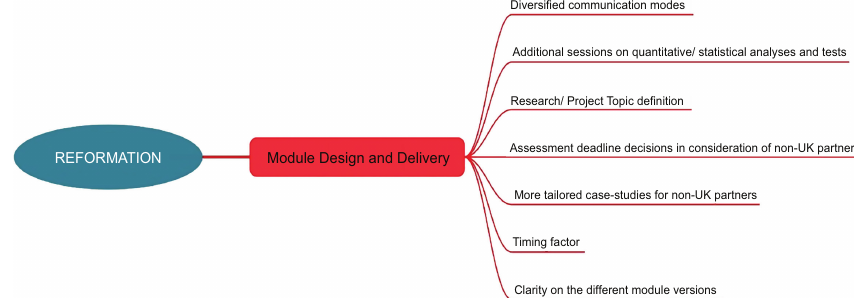
Figure 5. Interview